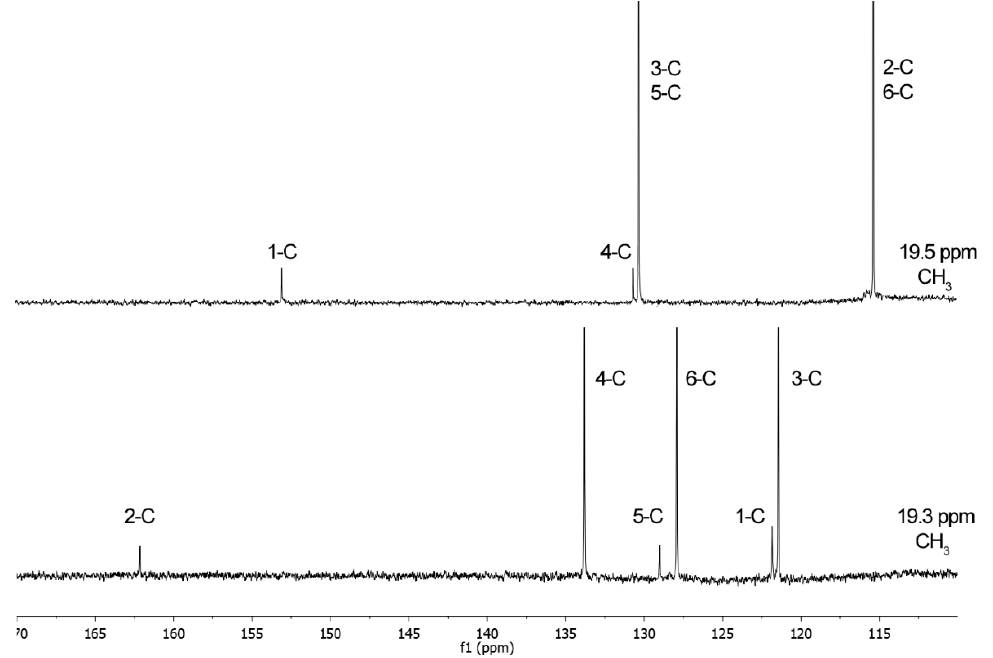
Figure 4. 13 C-NMR spectra of p CS ( 1 , top ) and 2-hydroxy-5-methylbenzenesulfonic acid ( 2 , bottom ).